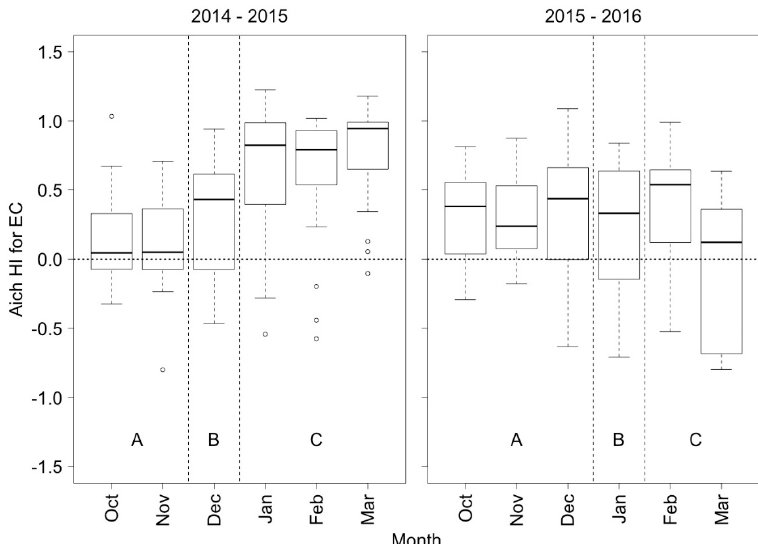
Figure 6. The hysteresis index (calculated following Aich et al. [28]) between water discharge and origin of runoff is split in snowmelt ( A ), snow and glacier melting ( B ) and glacier melting ( C ).